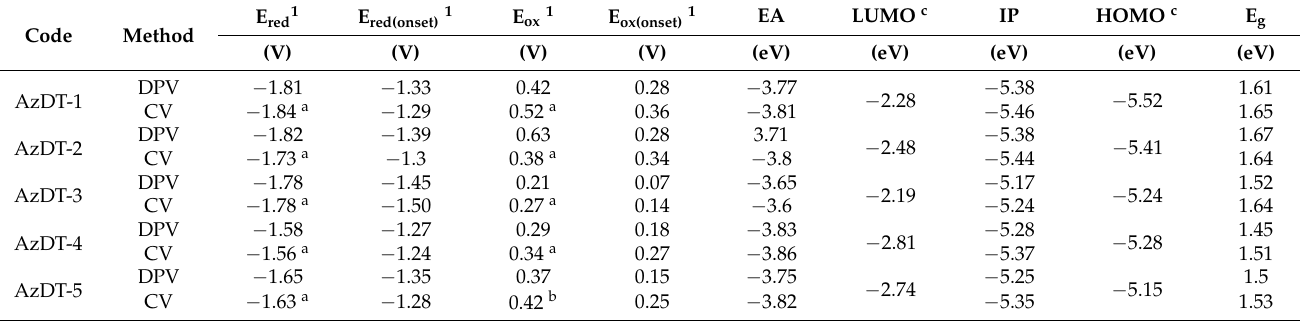
Table 2. The redox properties of the thiophenoazomethines.